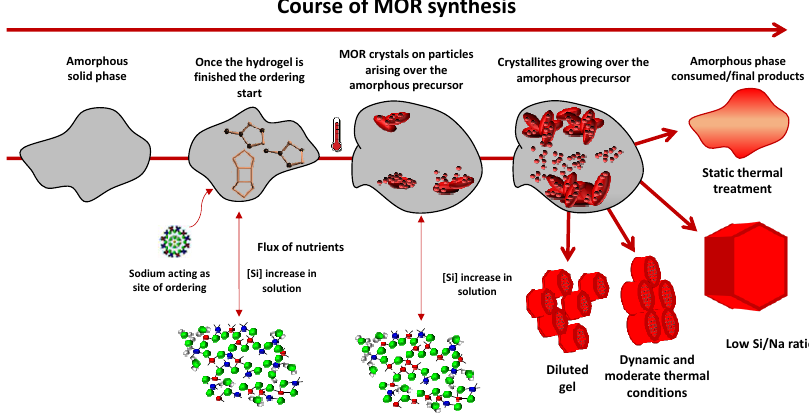
Figure 7. Schematic representation of mordenite particle formation based on the results of this study.